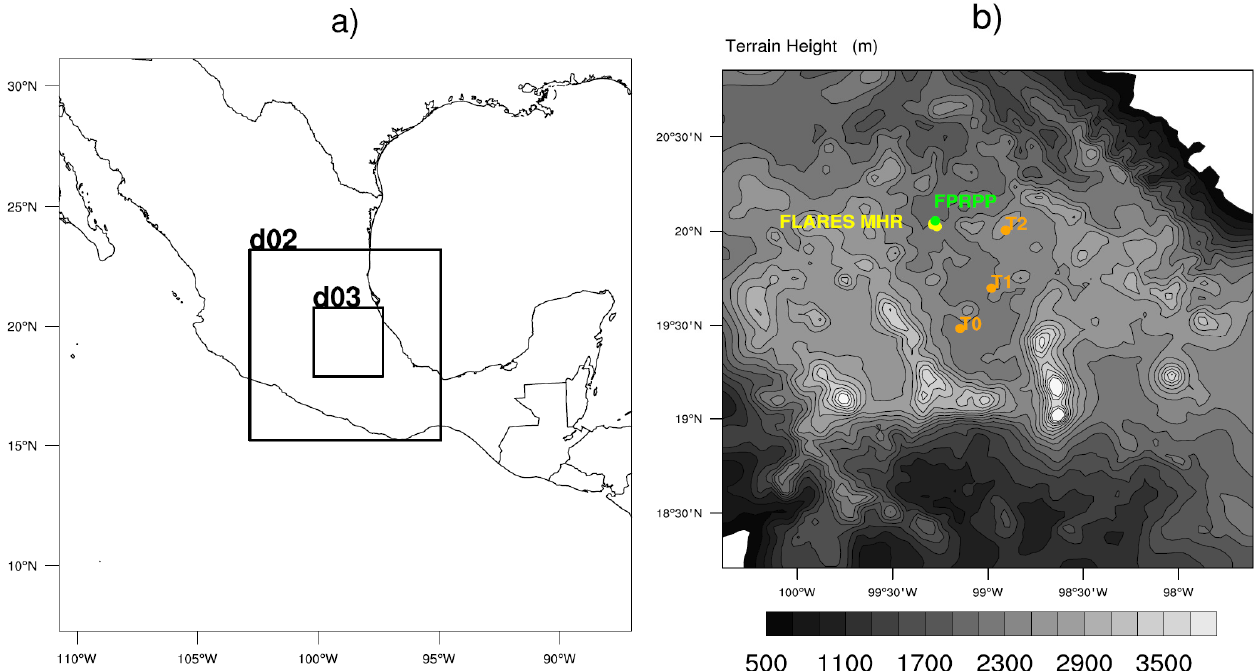
Fig. 1. (a) WRF-Chem model domain. d02 and d03 indicate the number of the nested domain. (b) Location of MILAGRO supersites (orange), FPRPP (green) and the elevated flares (yellow) at MHR in d03.